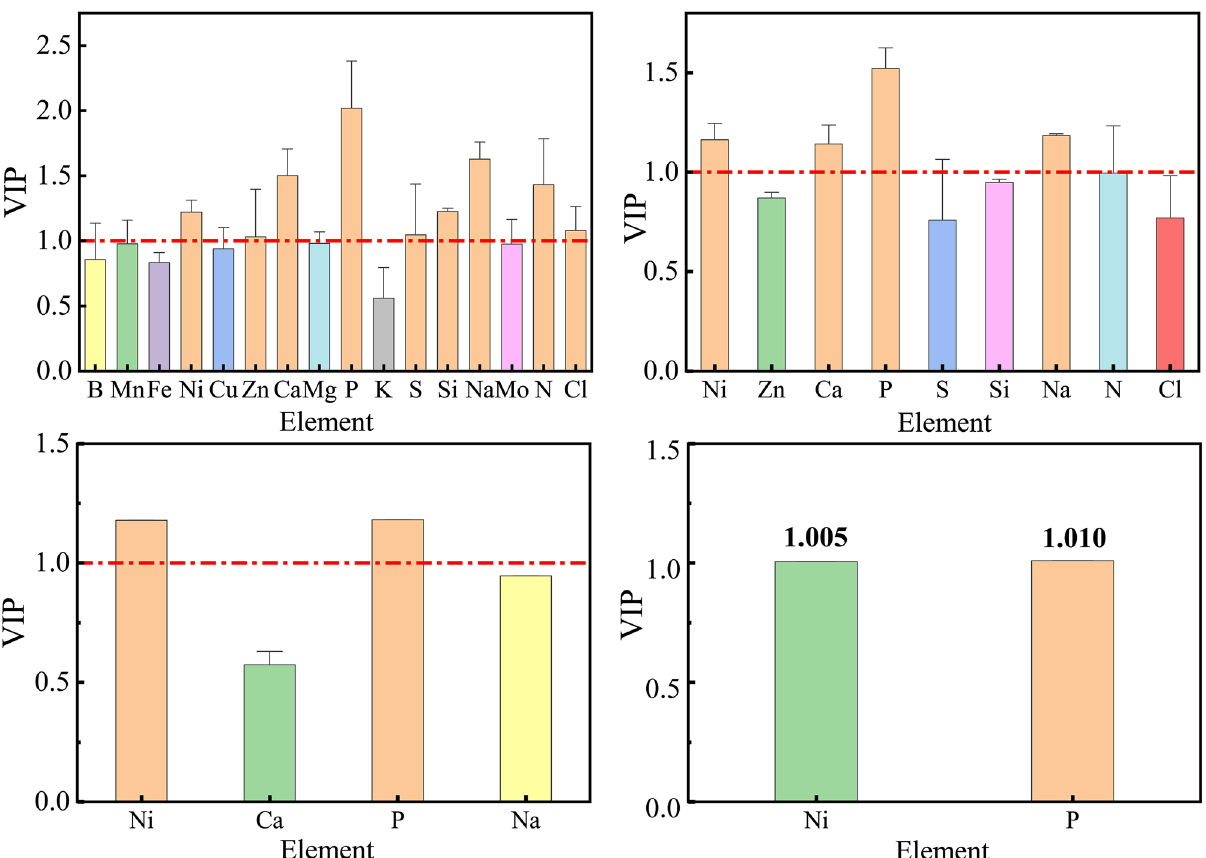
Figure 6. The projected importance (VIP) values of mineral